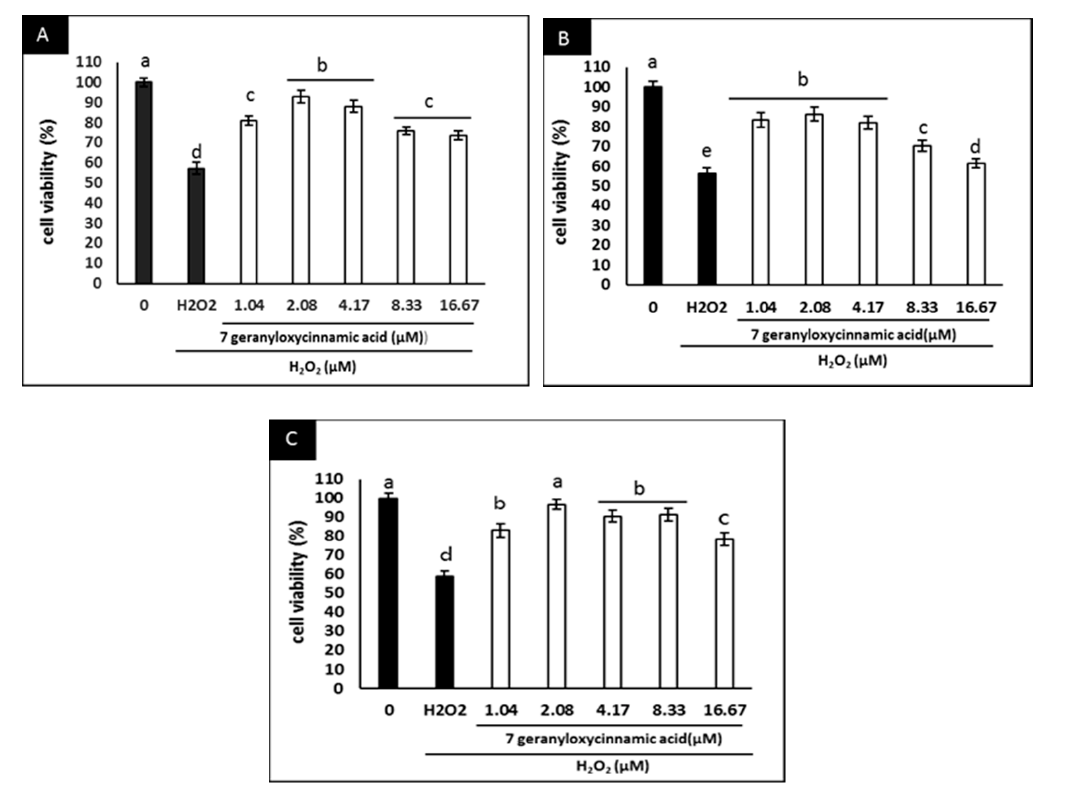
Figure 4. Neuroprotective effect of 7-geranyloxycinnamic acid at various concentrations (1.04–16.67 µM) in differentiated SH-SY5Y cells. The cells were incubated for ( A ) 24 h; ( B ) 48 h; ( C ) 72 h, and exposed to H 2 O 2 (300 µM) for 4 h. Data are displayed as means ± SD of triplicate experiments; means with different letters denote significant difference ( p < 0.05).